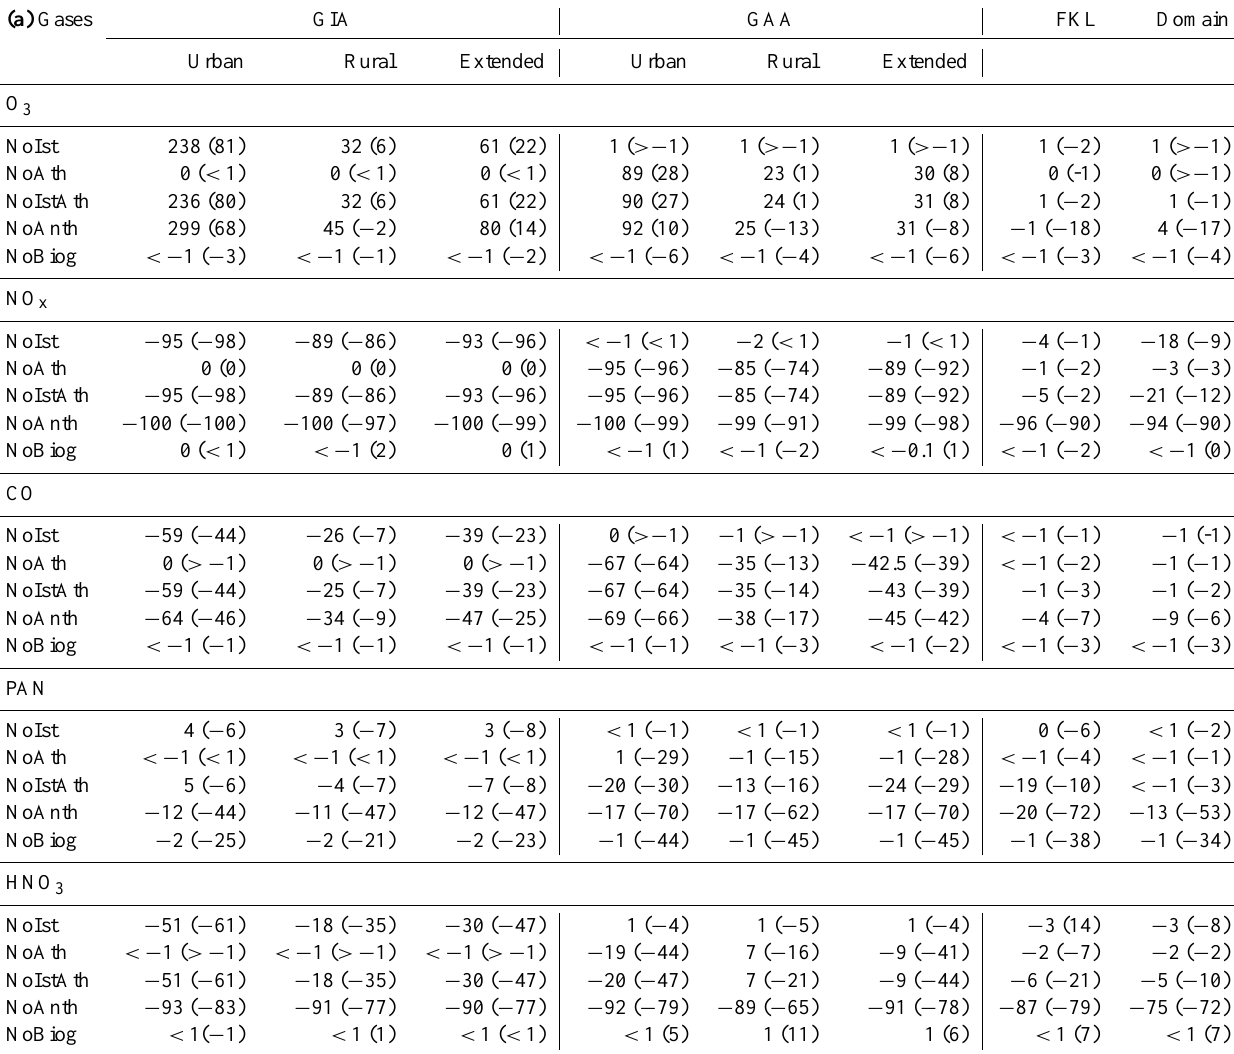
Table 5. Differences (%) in the mean winter (December 2008) and summer (July 2008; in parenthesis) surface concentrations of air pollutants and chemical indicators in GIA, and GAA (urban, rural suburbs and extended areas), at FKL and the whole domain due to masking of anthropogenic emissions from the GIA and/or GAA. Changes marked as > − 1 refer to values between 0 and − 1 and changes marked as < 1 refer to positive values. Values are computed as [100